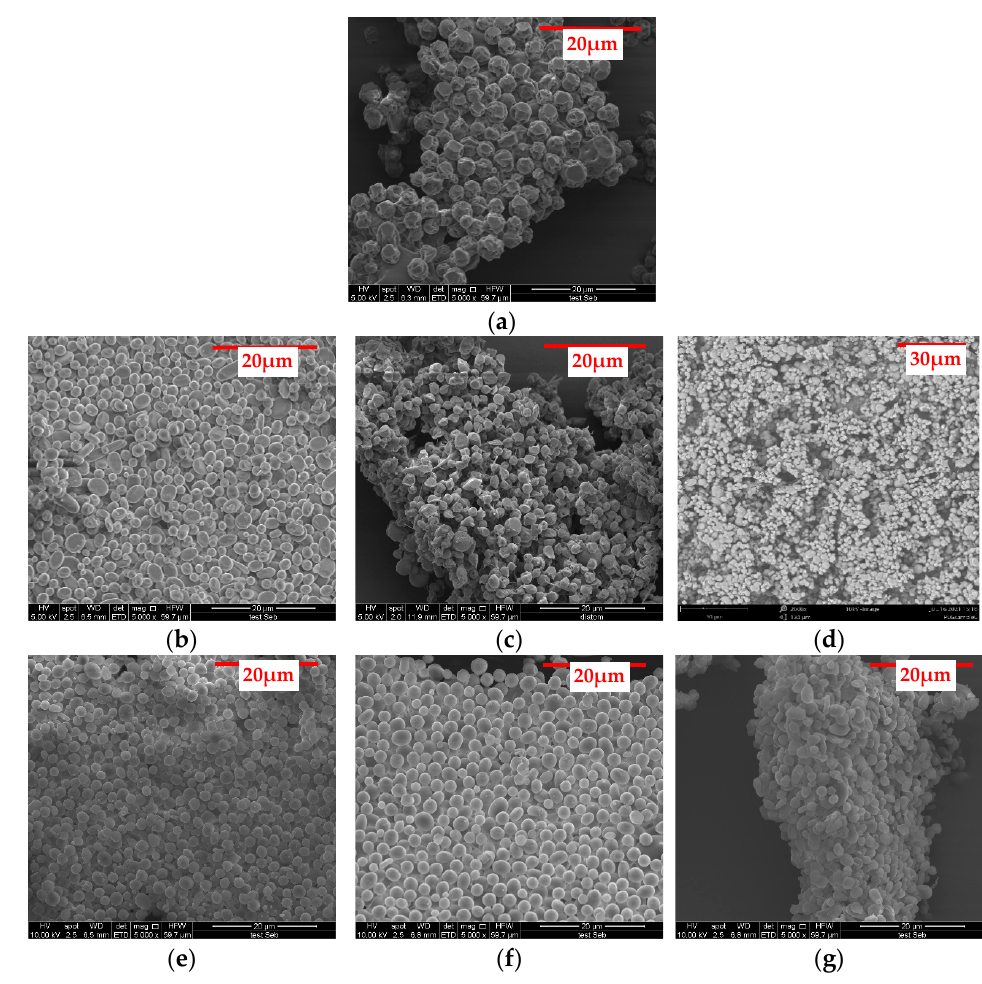
Figure 1. SEM images of KGN ‐ loaded particles prepared with ( a ) PLGA and PLGA combined with ( b ) PEG at 10% w / w ; ( c ) PEG at 30% w / w ; ( d ) PEG at 50% w / w ; ( e ) PVP at 10% w / w ; ( f ) PVP at 30% w / w ; and ( g ) PVP at 50% w / w . Scale bar: 20 μ m for all panels except ( d ) 30 μ m.